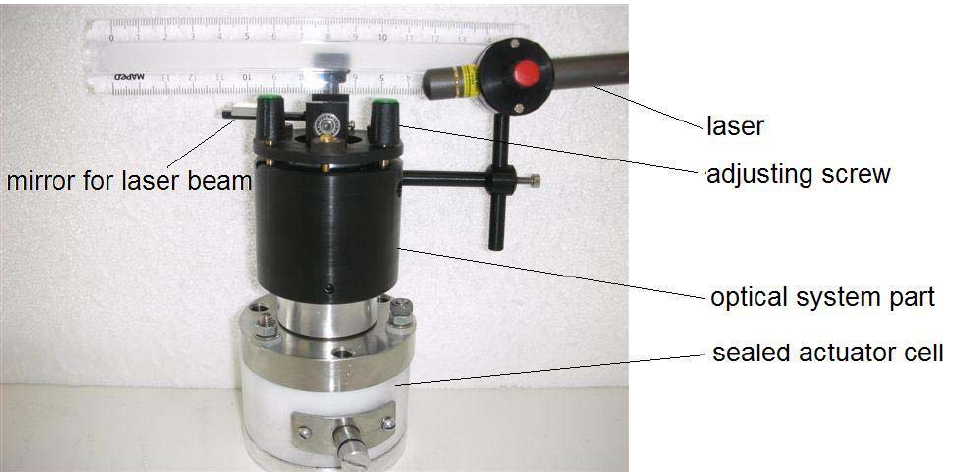
Figure 4. The linear actuator test cell.